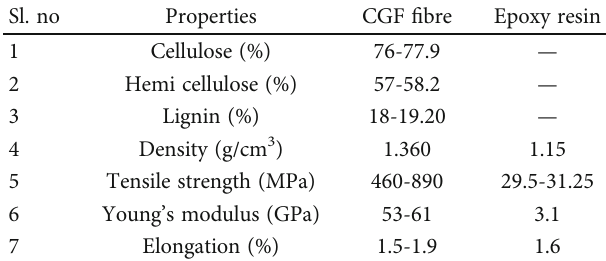
Table 1: Mechanical belongings of CGF and epoxy